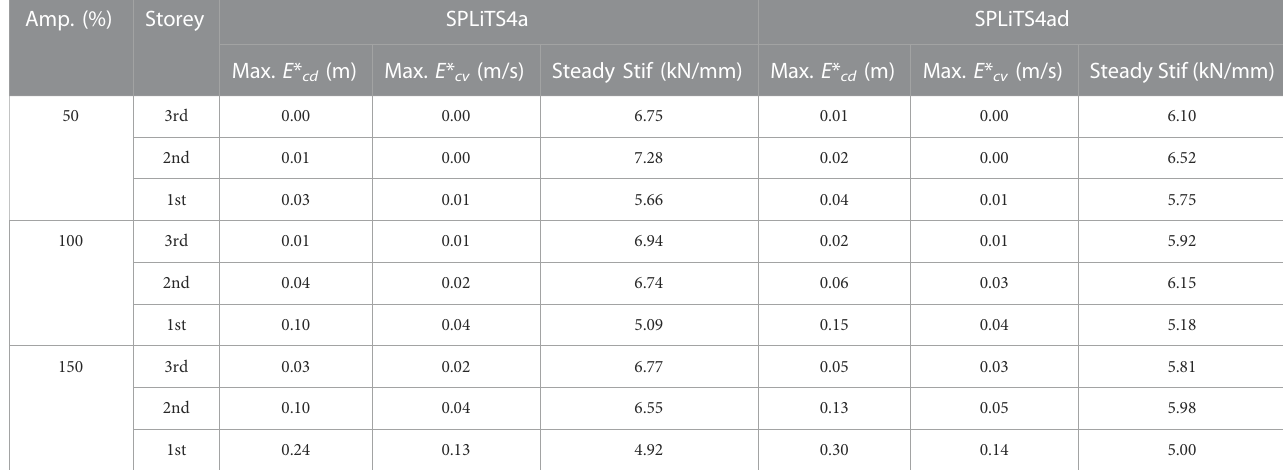
TABLE 3 Structural state indices estimated from the experiments using the Nankai motion. Amp.